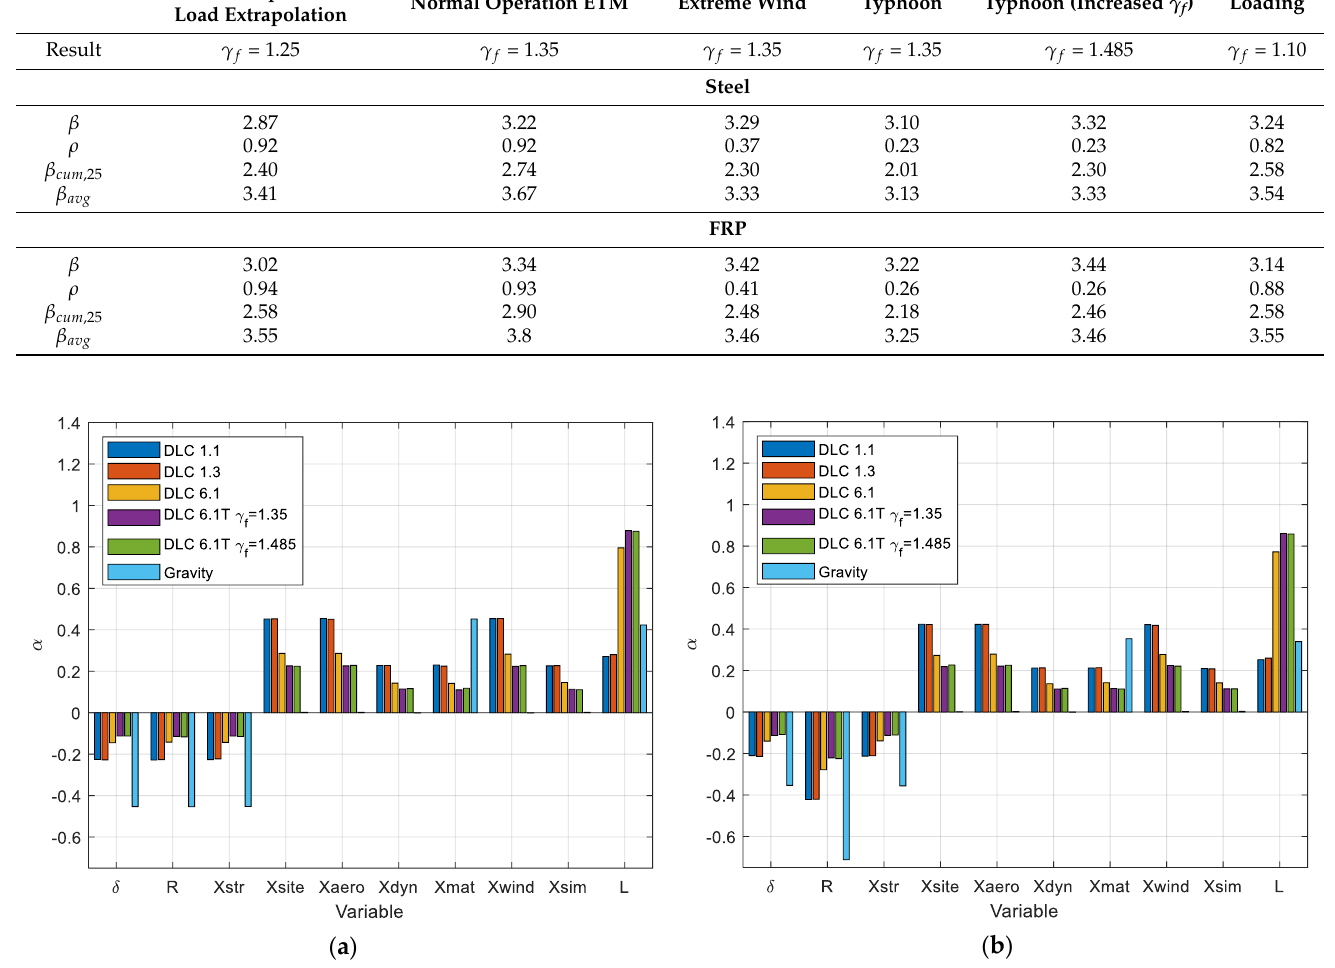
Figure 2. The 𝛼 -vector for ( a ) steel and ( b ) FRP for all load cases. Figure 2. The α -vector for ( a ) steel and ( b ) FRP for all load